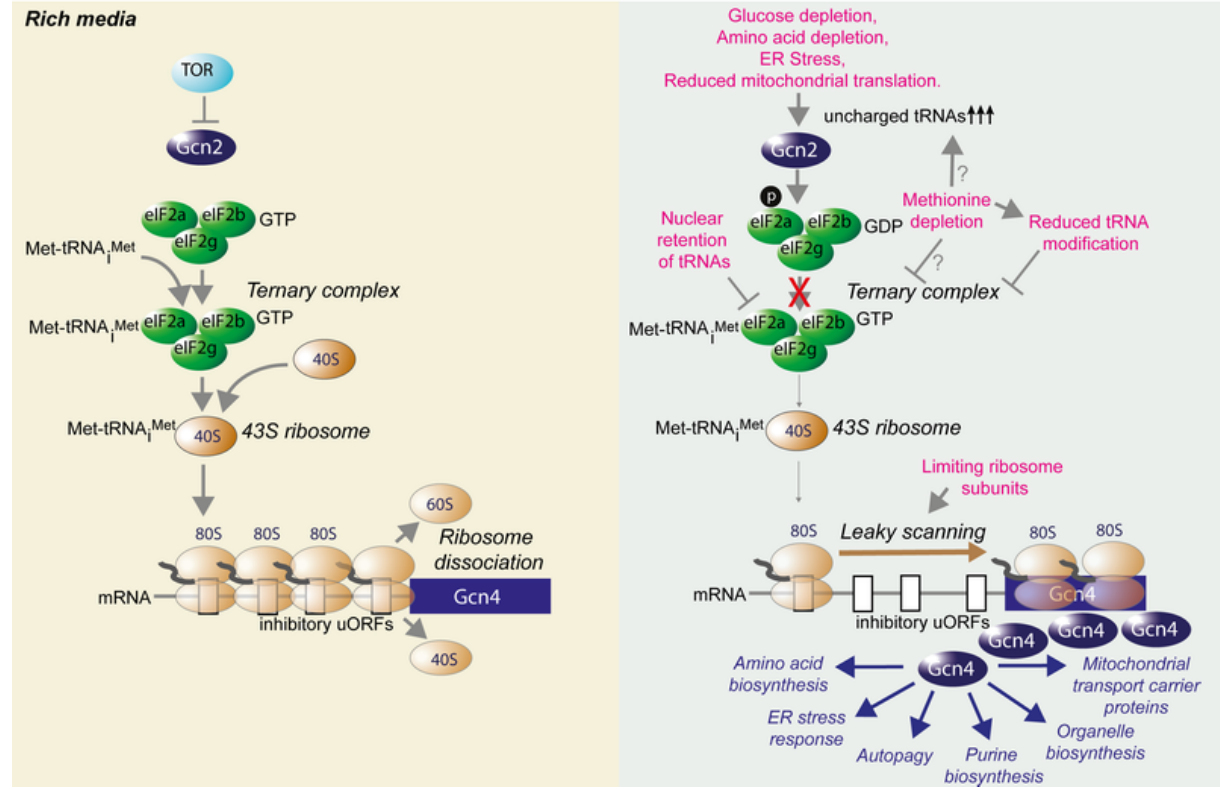
FIGURE 1: Overview of the yeast integrated stress response and how it is influenced by lifespan extending interventions. During growth in nutrient rich conditions, the ternary complex is formed from eIF2, methionine bound to tRNA iMet , and GTP, which then delivers Met-tRNA iMet to the 40S ribosome to make the 43S complex, which is a key rate-limiting step in translational initiation. Under rich growth conditions, efficient translation of the inhibitory upstream ORFs (uORFs) of the GCN4 mRNA causes dissociation of the ribosome, preventing it scanning along the mRNA to the protein coding ORF (blue). The regimens indicated in pink, which all extend RLS, either result in increased abundance of uncharged tRNAs that activate Gcn2 to phosphorylate eIF2α to prevent formation of functional eIF2-GTP, or they activate Gcn4 in a Gcn2- independent manner, in conditions that reduce formation of the ternary complex directly (reduced amounts of processed tRNAs in the cy- toplasm, reduced amino acids) or via reduced amounts of ribosomal subunits. In either case, the end result is inefficient 80S ribosome for- mation, which promotes leaky scanning along the mRNA to the protein coding ORF of GCN4. The resulting Gcn4 protein induces transcrip- tion of genes required for the indicated stress response